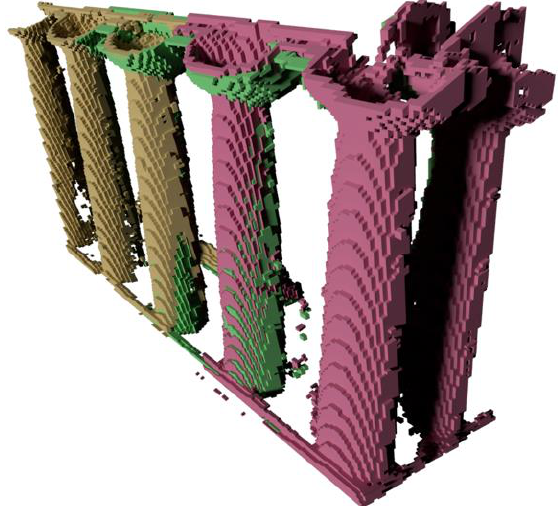
Figure 6: Reconstruction of a part of the Cerere temple using three adjacent